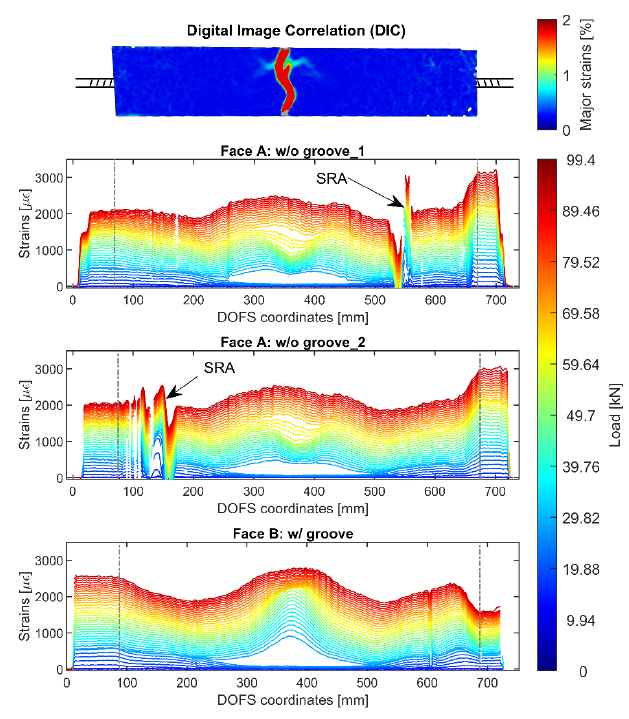
Figure 17. DOFS extracted profiles of member 12D16_60 as monitored by three runs of the same fiber, two on Face A and one on Face